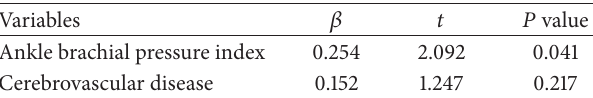
Table 3: Multivariate analysis for the association of endothelial function with various